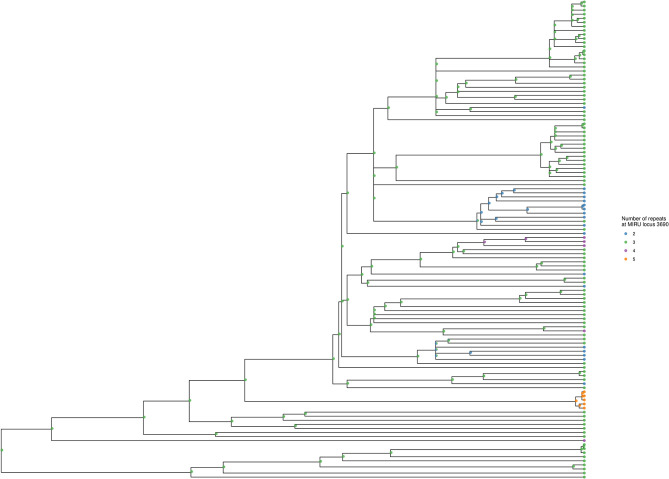
Ancestral state reconstruction for locus 3690, shown for Lineage 2 subtree. The tree corresponds to the Lineage 2 subtree from Figures 3, 4. Tips are colored to designate the number of repeats at locus 3690 for each isolate. Internal nodes show the ancestral state likelihoods, generated using the maximum likelihood method of R phytools::rerootingMethod (38), and displayed as a pie chart with the same color scheme as the tips. The tree was generated using R ggtree (41).